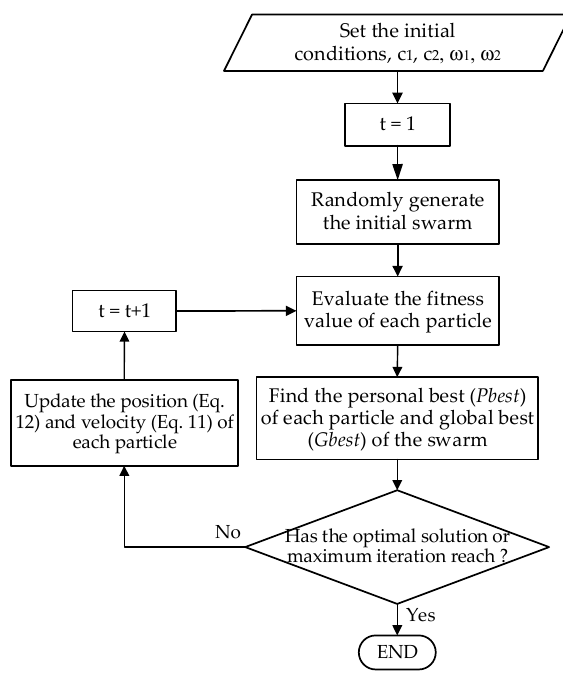
Figure 2. Flow chart of the PSO algorithm.